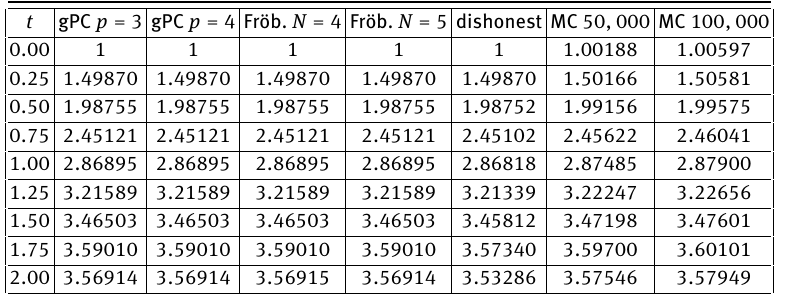
Table 4: Approximation of E [ X ( t )] . Example 4.1, assuming dependent random